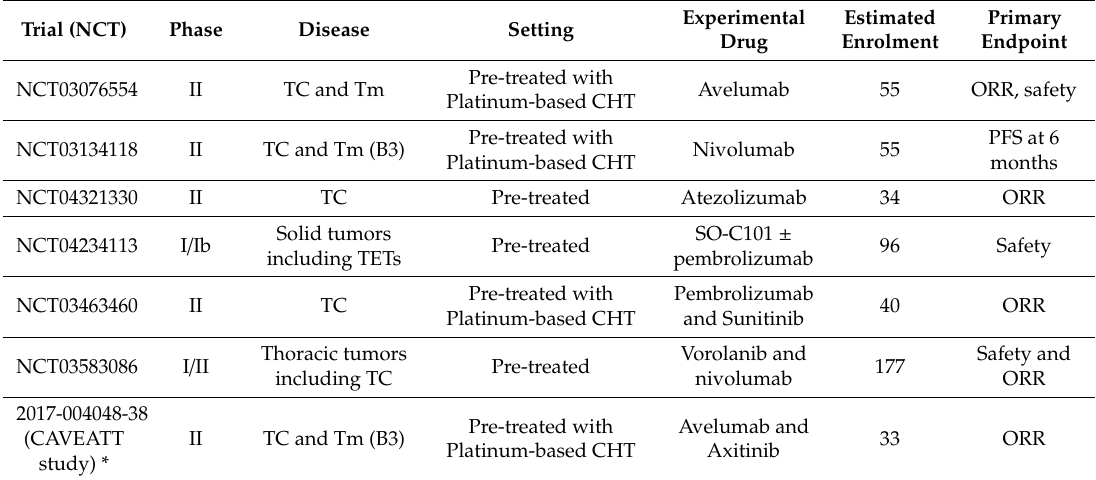
Table 2. Active and recruiting clinical trials of immune checkpoint inhibitor (ICI) monotherapy and combinations (source: clinicaltrials.gov; last accessed: 26 October